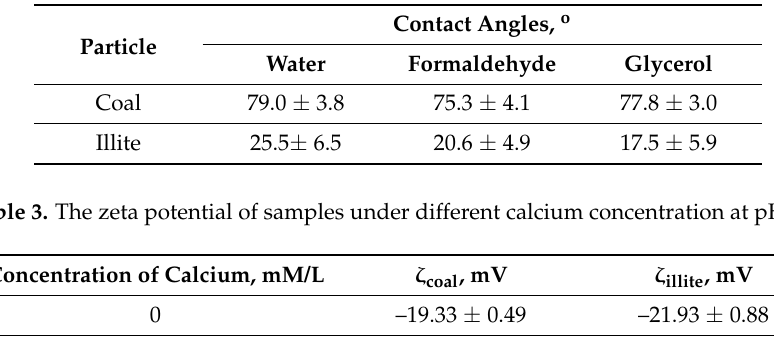
Table 2. The contact angles of coal and illite in three liquid mediums at pH 8.2.